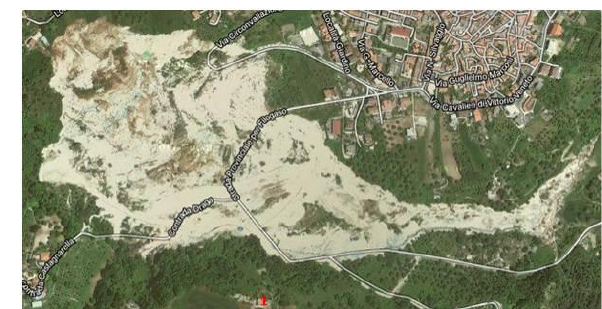
Figure 5. Aerial view of the Maierato Landslide